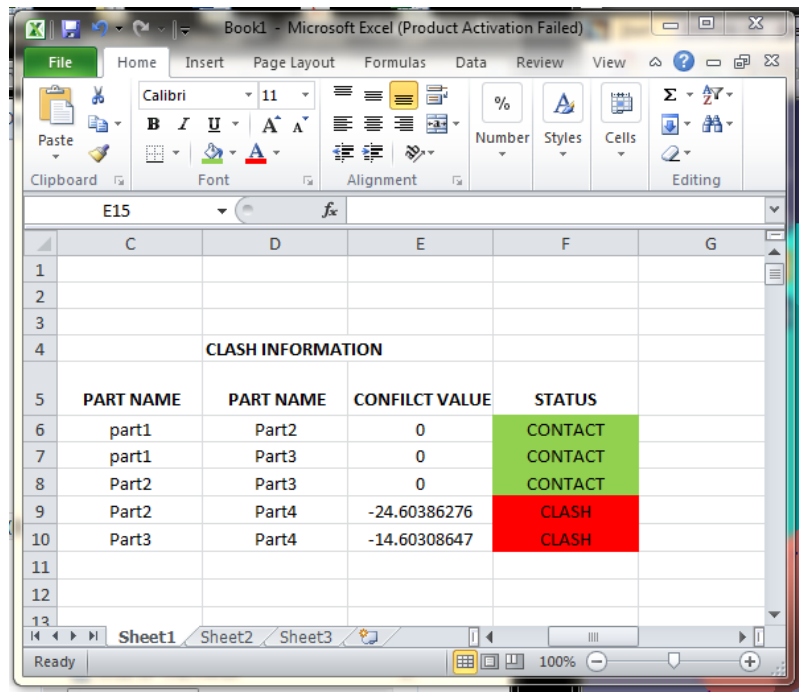
Figure 3. Represents the clash information of block